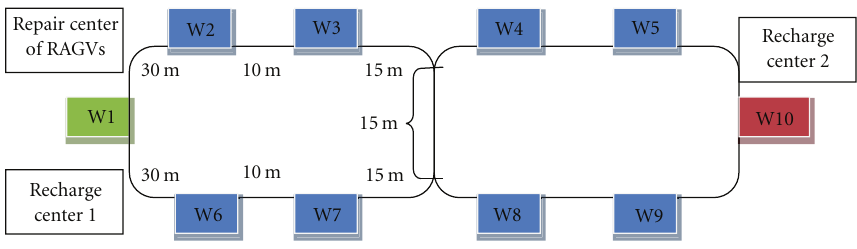
Figure 2: Flow path layout of the FMS: the distance at the right cell is the same as that at the left one. All routes are bidirectional except the one between W8 and W9. Table 2: The nondeterministic variables and product sequence.